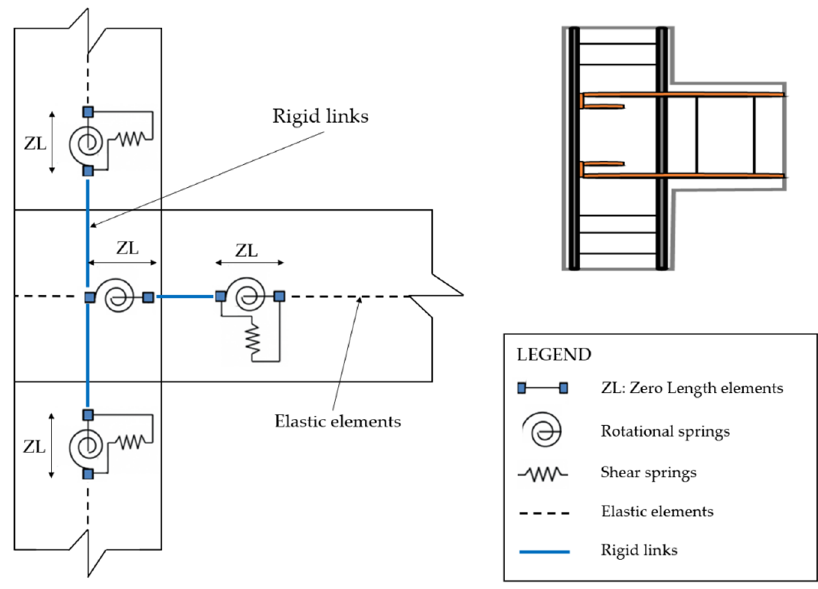
Figure 3. Details of the FE model of the beam-column joint.